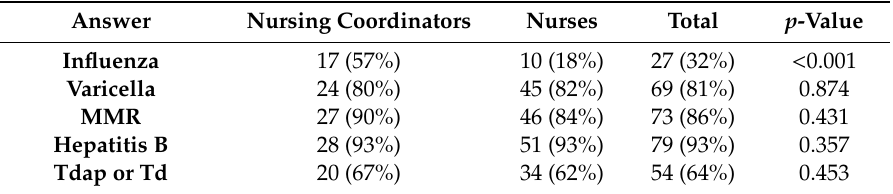
Table 5. Frequency distribution (values and percentages) and p -value (Yates’s chi-squared test) of the answers to the statement “You get vaccinated